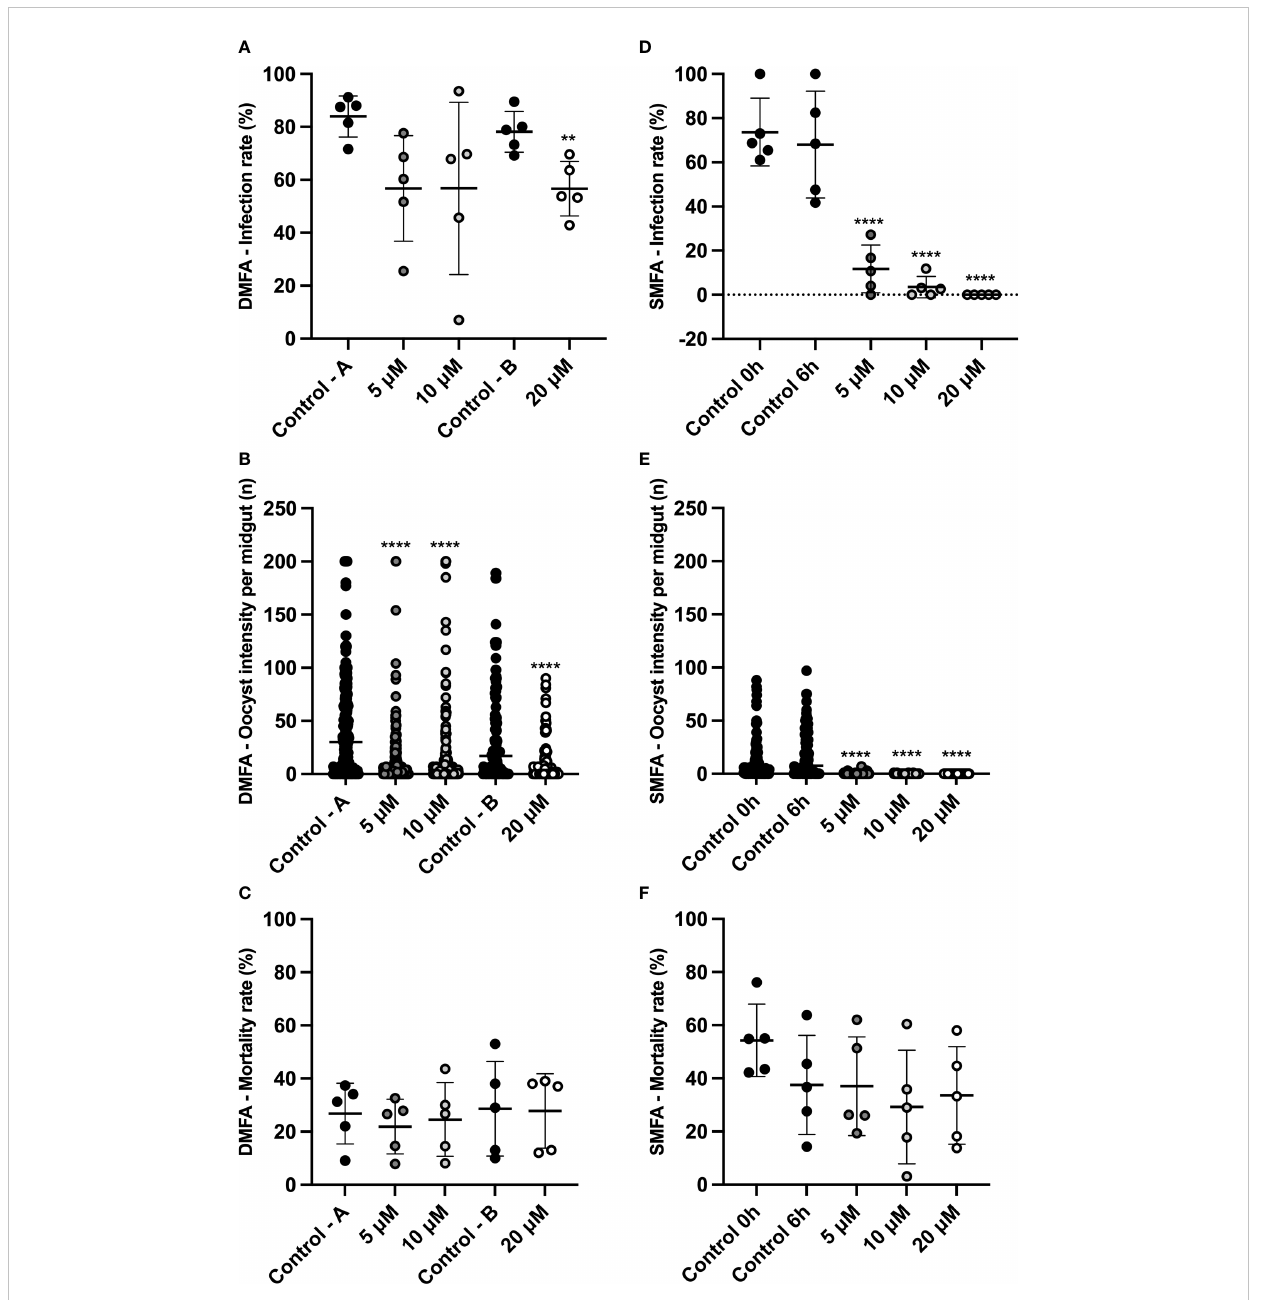
FIGURE 2 MB transmission-blocking activity for Plasmodium vivax using DMFA and SMFA. DMFA infection rate (% of mosquitoes with the presence of 1 or more oocyst in the midgut)) (A) . DMFA intensity (mean oocysts per infected midgut) (B) . DMFA mortality (mean number of dead mosquitoes at seven days post-infection) (C) . SMFA infection rate (% of mosquitoes with the presence of 1 or more oocysts in the midgut) (D) . SMFA intensity (mean of oocysts per infected midgut) (E) . SMFA mortality (mean number of dead mosquitoes seven days post-infection) (F) . Both assays were evaluated in fi ve independent experiments (isolates) by feeding An. aquasalis with blood without MB (Control A, B, 0 h, and 6 h) or blood with different concentrations of MB (5, 10, and 20 μM). DMFA infection rate p - values were calculated using one-way ANOVA with Tukey ’ s multiple comparisons tests (for Control A, 5 m M, and 10 m M concentrations) and the unpaired t-test (for control B and 20 m M concentration). DMFA infection intensity p- values were calculated using the Kruskal-Wallis test followed by Dunn ’ s multiple comparison post-test (for Control A, 5 m M, and 10 m M concentrations) and the Mann-Whitney test (for control B and 20 m M concentration). SMFA infection rate p-values were calculated using one-way ANOVA with Tukey ’ s multiple comparisons tests, and infection intensity was calculated using the Kruskal-Wallis test followed by Dunn ’ s multiple comparisons post-test. Asterisks (**) and (****) represent signi fi cant differences (p <0.01 and p <0.0001, respectively) in relation to control A or control B (for DMFA) and control 6 h (for